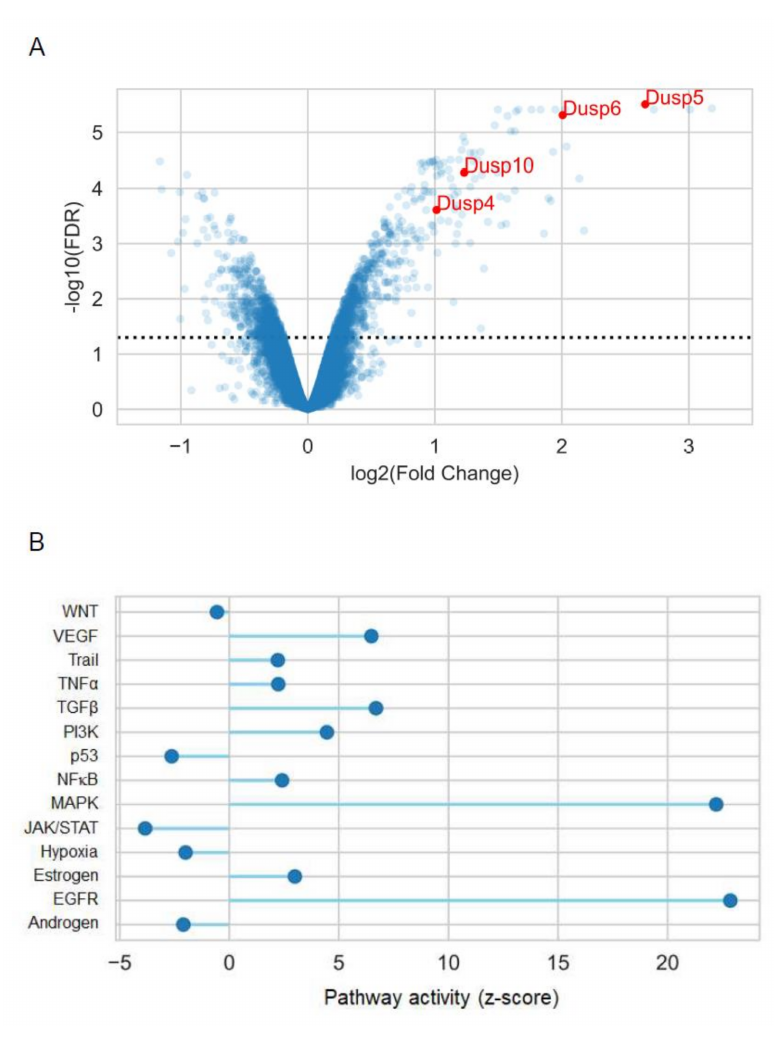
Figure 1. AngII-induced gene expression changes in VSMCs. ( A ) Differential expression (DE) analysis was performed between 2-hour AngII- and vehicle-treated samples. The microarray experiment was performed in triplicate. The results of DE analysis are shown as a volcano plot ( x -axis: log2 fold change, y -axis: − log10 (FDR, false discovery rate), based on the Benjamini–Hochberg correction of p-values. Selected members of the DUSP family are color-coded and text-labeled. The dotted line shows the significance threshold (FDR < 0.05) ( B ) PROGENy pathway analysis of an AngII-induced gene expression signature. Pathway activity was calculated for 14 PROGENy pathways ( x -axis) and normalized to z-scores ( y -axis), based on a random permutation of gene